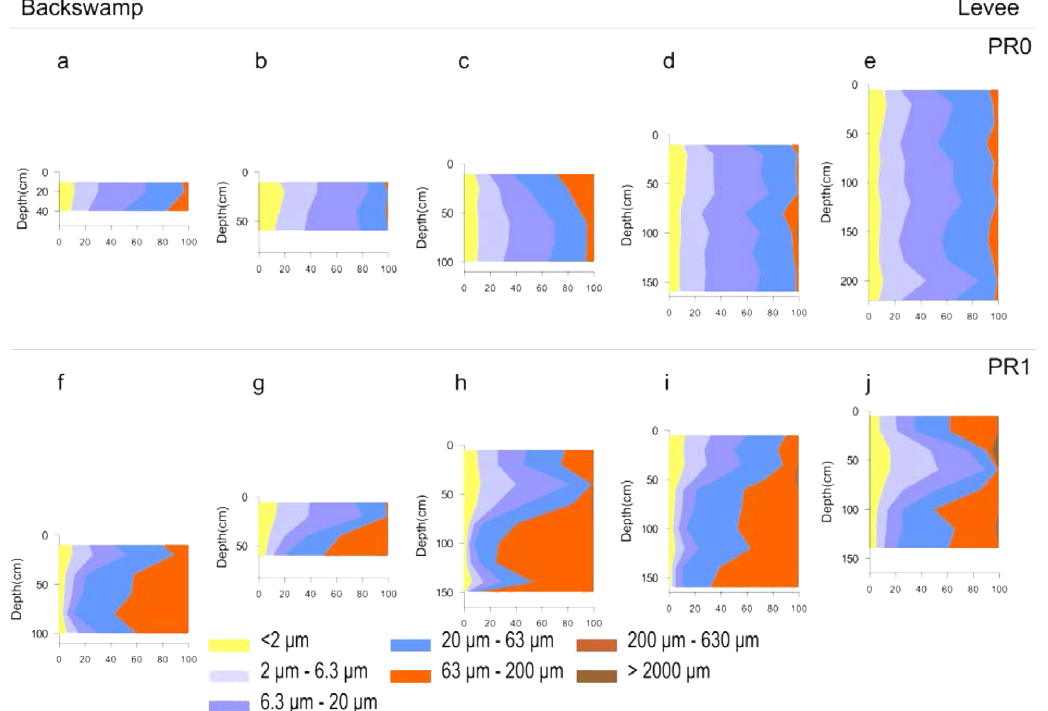
Figure 7. Grain size distribution along the soil profiles of the PR0 and PR1